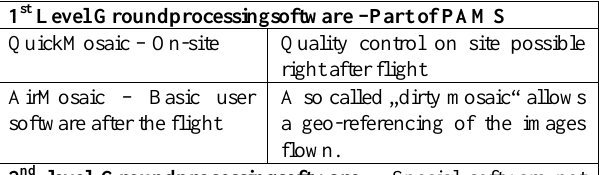
Table 3: PAMS evaluation software